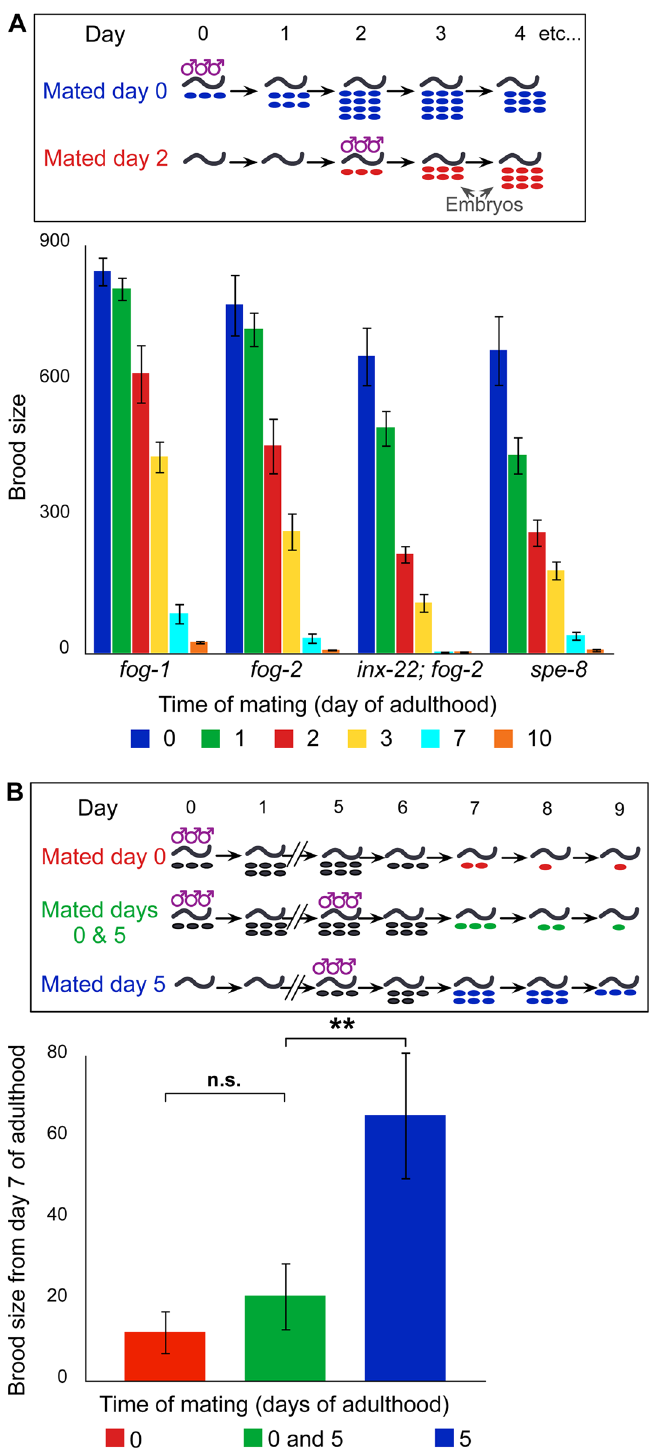
Fig 1. Reproductive senescence rates correlate with gonad activity. (A) Schematic of reproductive senescence assay, and brood sizes of females of various genotypes mated at increasing ages (n = 15 – 40 mothers for each genotype and time point). (B) Schematic of late reproductive activity assay, and brood sizes from day 7 for females mated at the onset of adulthood (day 0), on day 5 of adulthood, or both. For statistical tests see S1C Table. Error bars represent 83% confidence intervals; asterisks indicate significance of Wilcoxon rank sum test p-value.